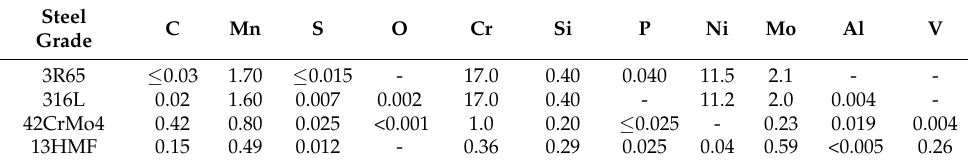
Table 1. The chemical compositions of the studied steel grades (mass%).